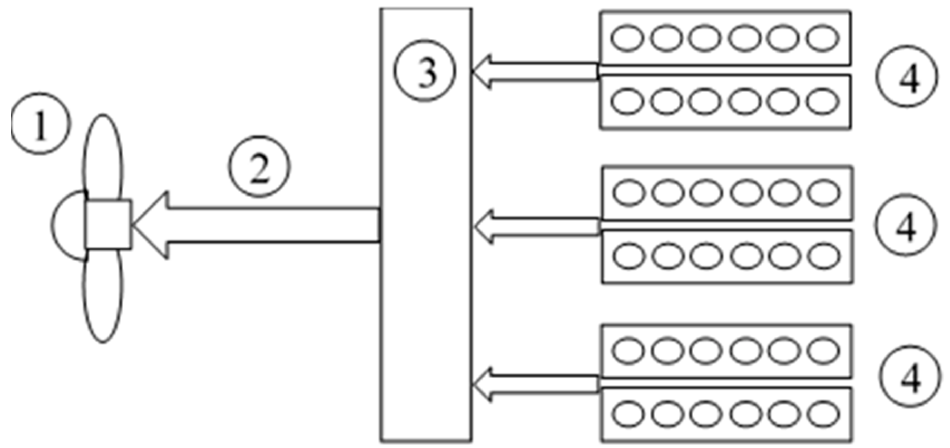
Figure 5. Propulsion with three medium-speed diesel engines (Legend: 1—propeller, 2—propeller